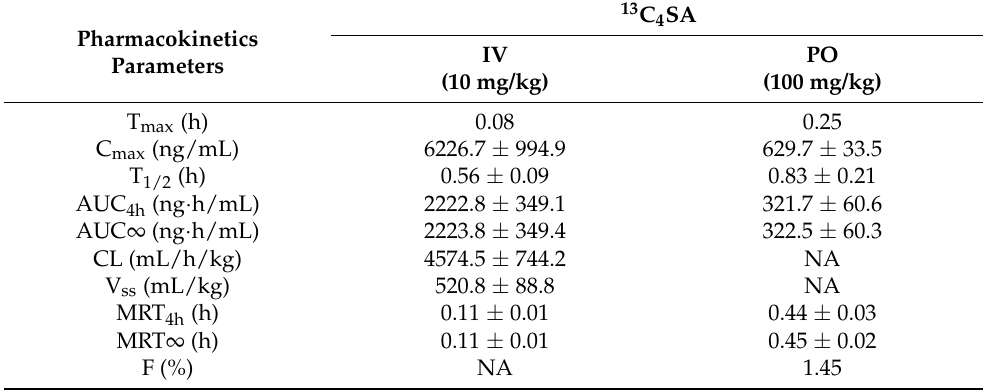
Table 5. 13 C 4 SA pharmacokinetic parameters in plasma (mean ± SD, n = 3).